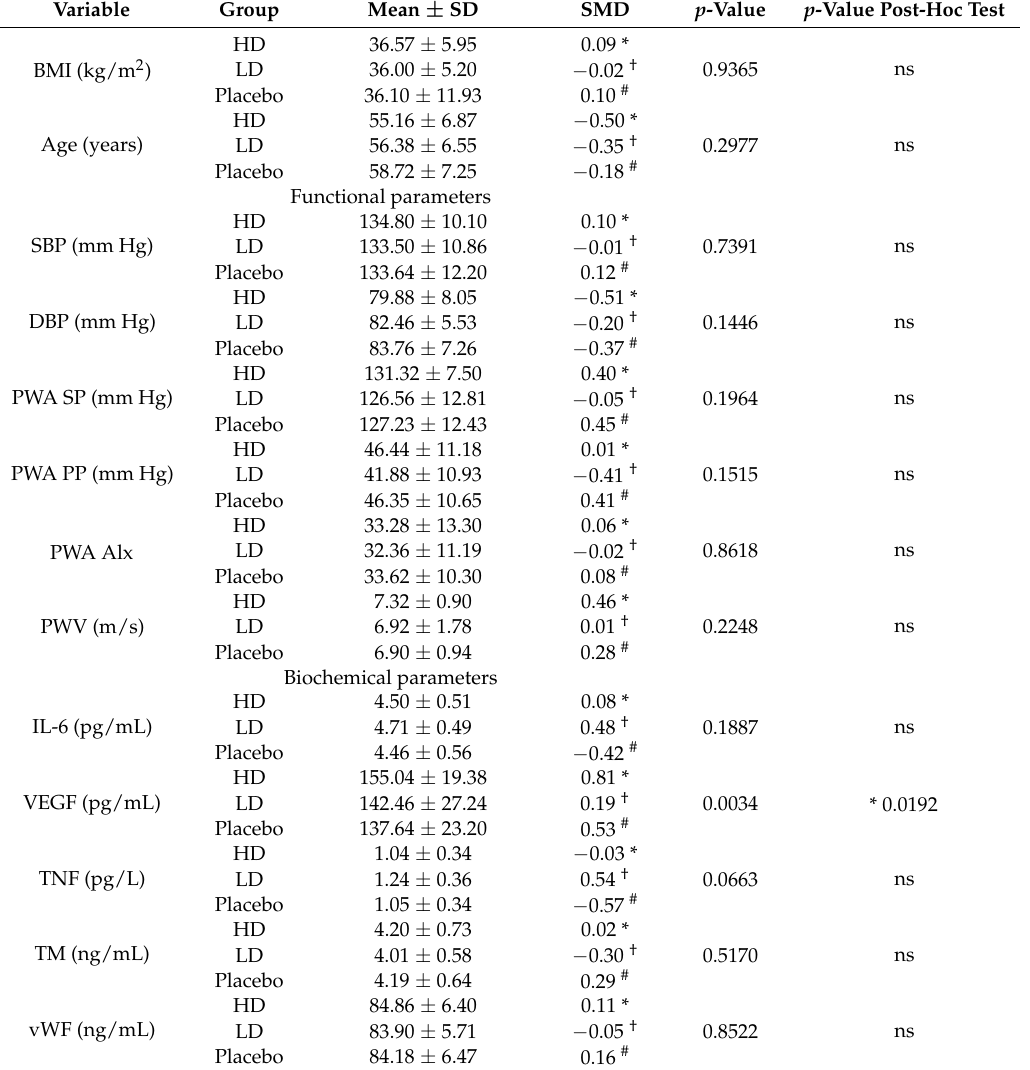
Table 1. The baseline characteristics of studied parameters in the high dose (HD), low dose (LD), and placebo